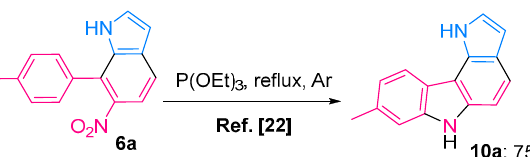
Scheme 3. Classic conditions for the Cadogan reaction ([22]) applied to 6a .